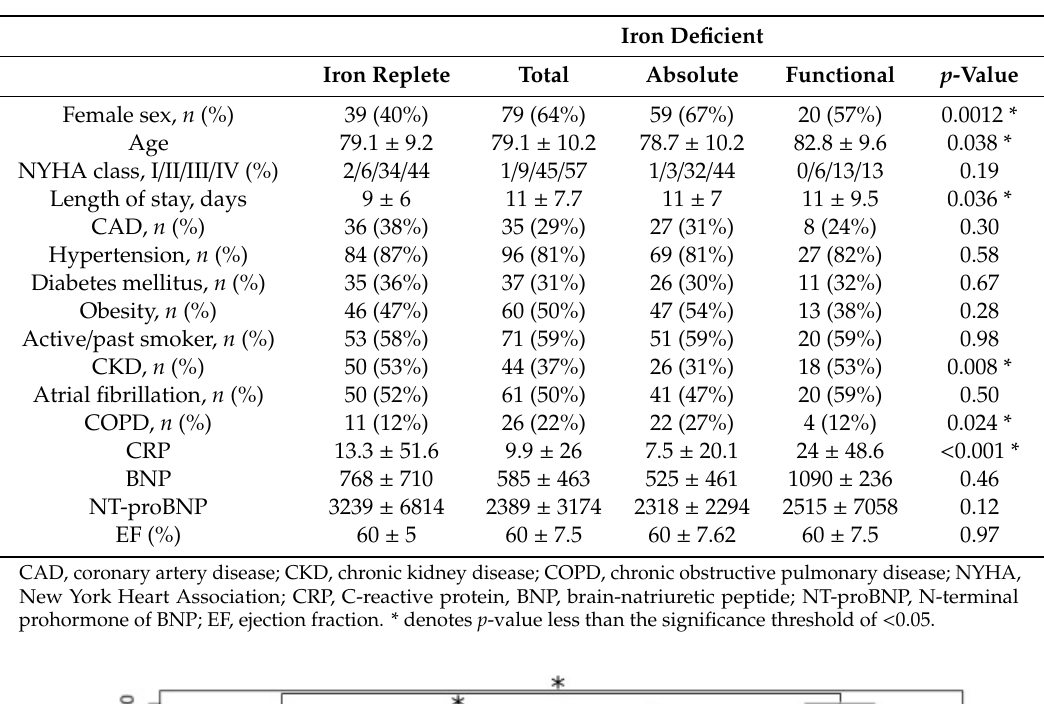
Table 2. Patient characteristics, biomarker levels and diastolic function indices on TTE according to iron status in the HFpEF cohort.